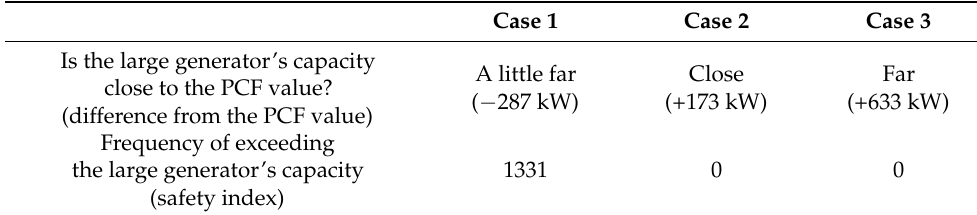
Table 6. Checklist for practical consideration.